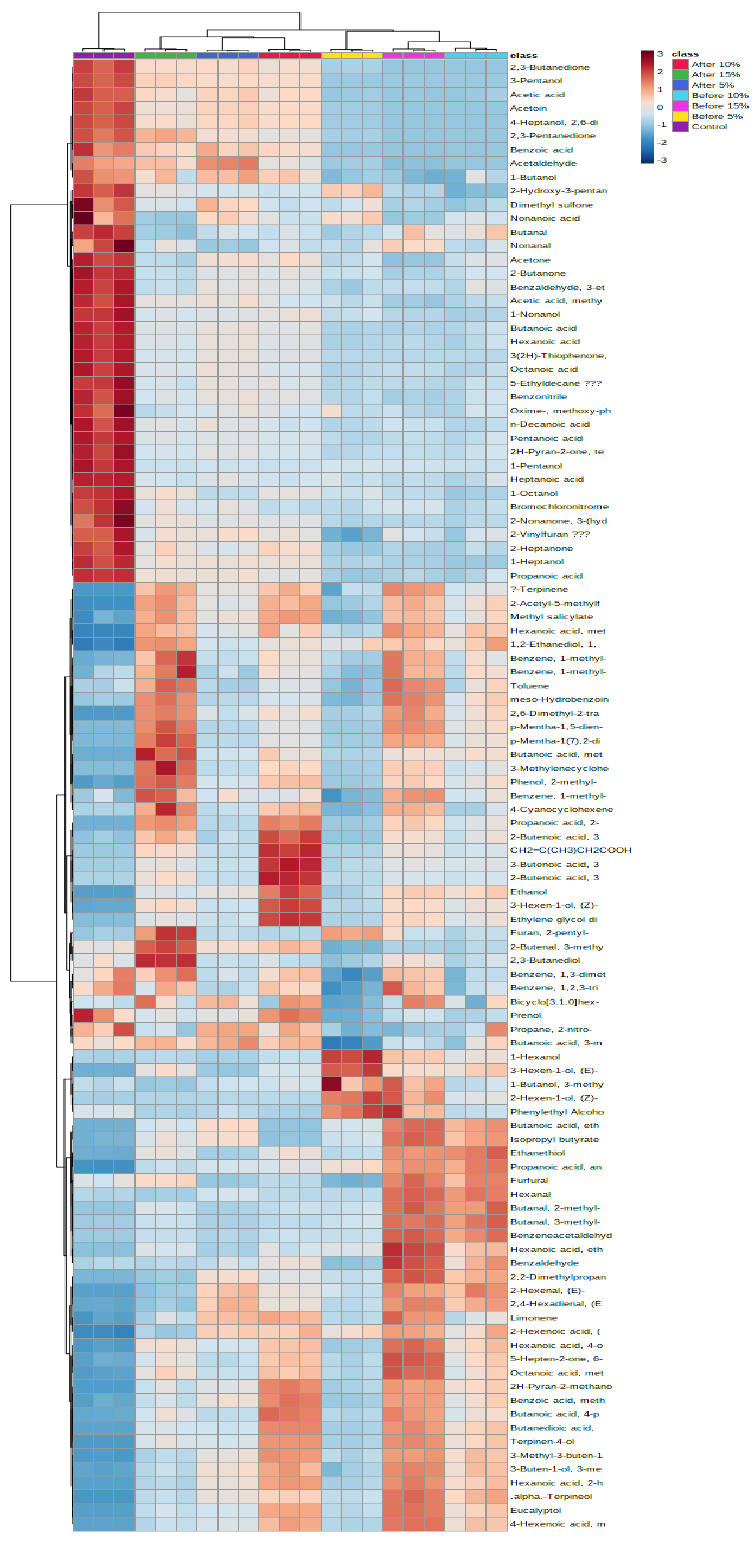
Figure 1. Score plot ( A ) and heatmap ( B ) diagrams from the principal component analysis of the relative concentration of volatiles for control yoghurt and tamarillo yoghurts produced from two fermentation processes. The vertical bar (3 to − 3) from deep red to deep blue shows high to low levels of each volatile in different groups of yoghurt samples.